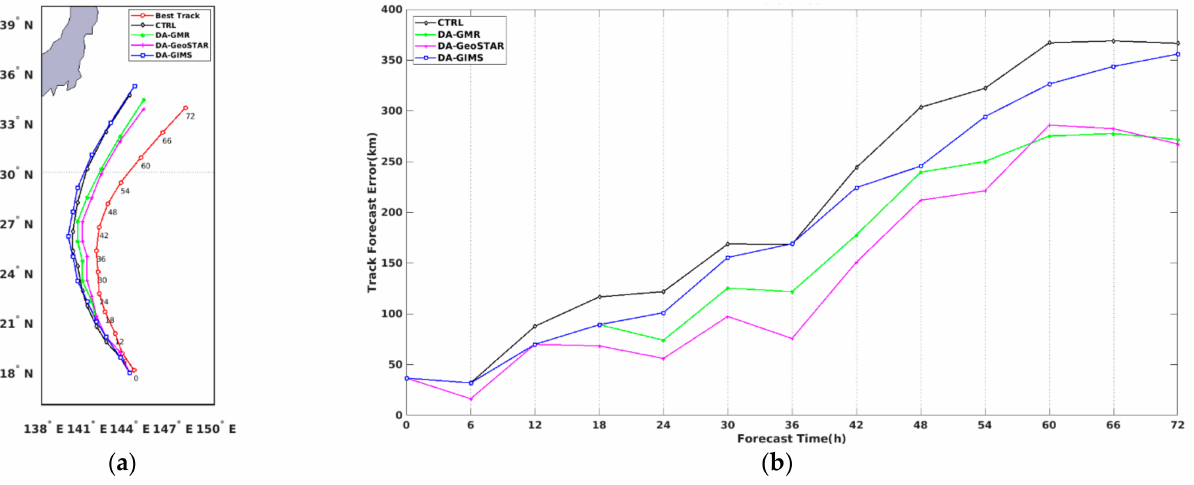
Figure 15. The predicted track of Bualoi initialized from 06:00 UTC on 22 October 2019 ( a ) and track forecast errors ( b ). The red curve in ( a ) represents the best typhoon track